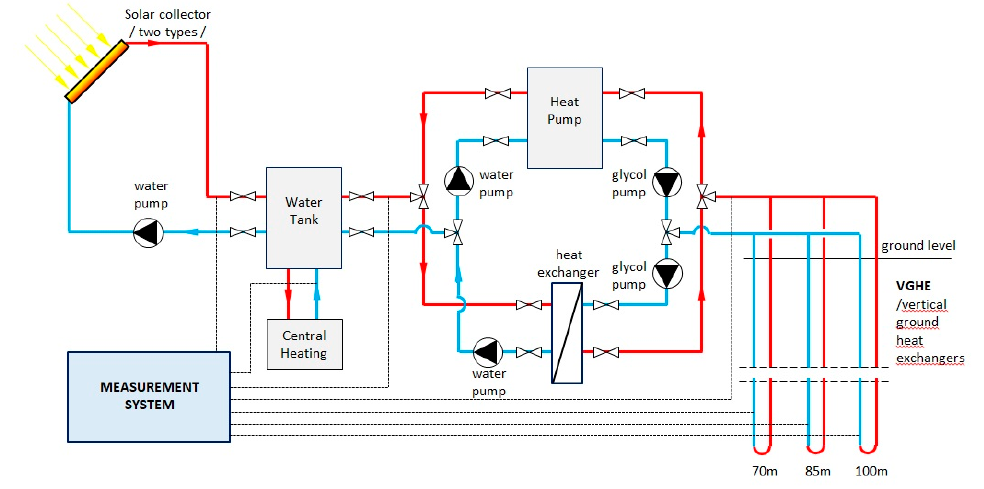
Figure 1. A ground source heat pump seasonal storage system based on a heat